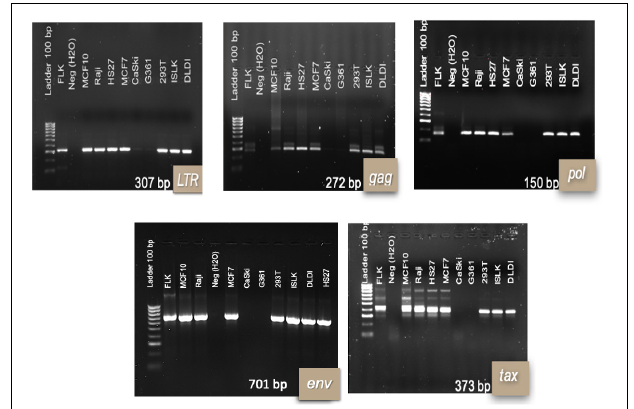
FIGURE 1 | Bovine leukemia virus genes’ fragments for infected human cell lines at time 0 post-infection. 1.5% agarose electrophoresis gels with representative results per cell line. Results are shown at 48 hpi of the TransWell system. Each infection of the cell lines was repeated twice in two independent moments. DNA from FLK cell line was used as a positive control for PCR reactions.